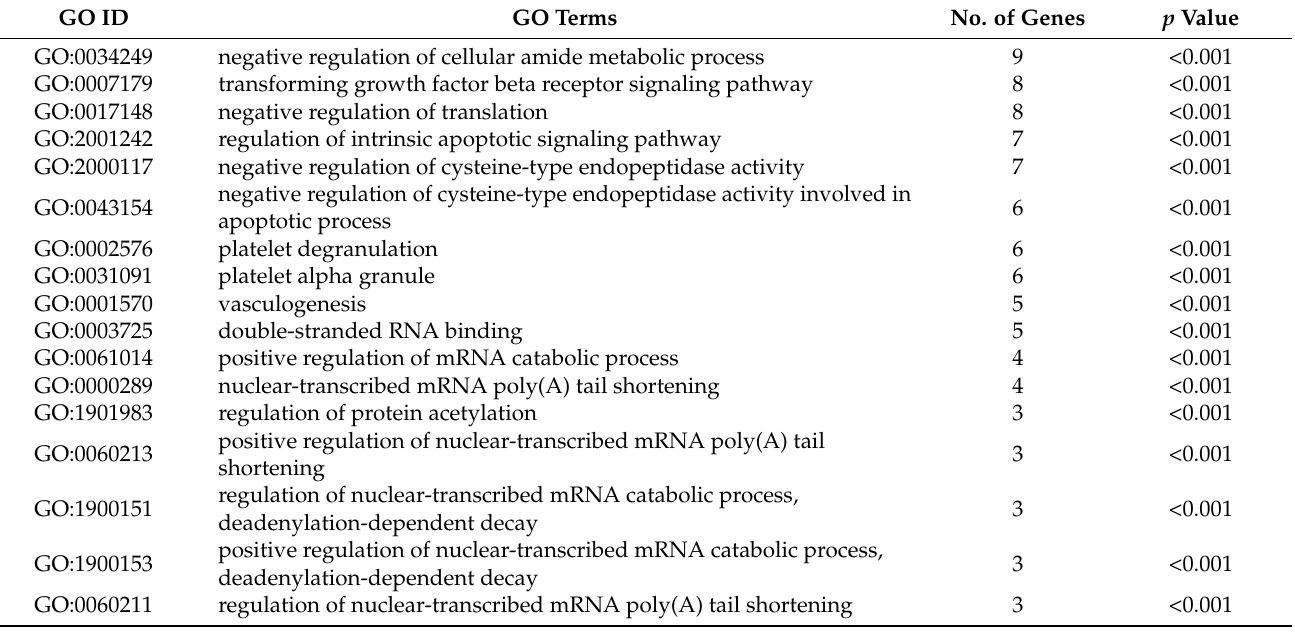
Figure 4. miRNA–mRNA interaction network analysis and gene ontology (GO) enrichment analysis of target genes. ( a ) The top six miRNAs were uploaded to the miRNet database and. A significant miRNA–target gene network was constructed; miR-199b-3p (blue), miR-16-5p (orange), miR-199a-3p (green), miR-374c-5p (yellow), miR-6856-3p (purple), and miR-6886-3p (pink). ( b ) GO enrichment analysis of target genes, with the top six differentially expressed miRNAs represented as functionally grouped networks of enriched GO terms generated by ClueGo. The parameters of ClueGO were set as follows: GO term fusion selected; only display GO terms with p < 0.05 in Bonferroni step-down analysis; kappa score of 0.4. Table 3. List of gene ontology terms for predicted target genes of the top six differently expressed